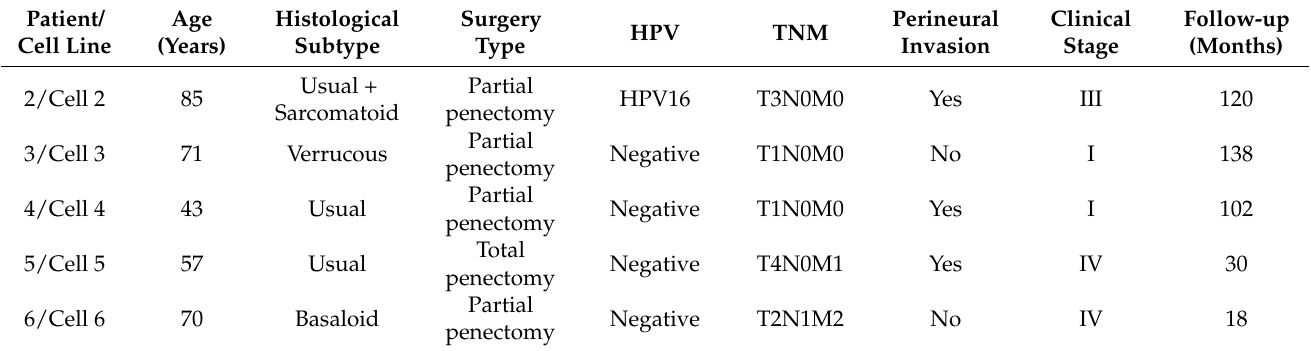
Table 1. Clinical and pathological characteristics of penile cancer